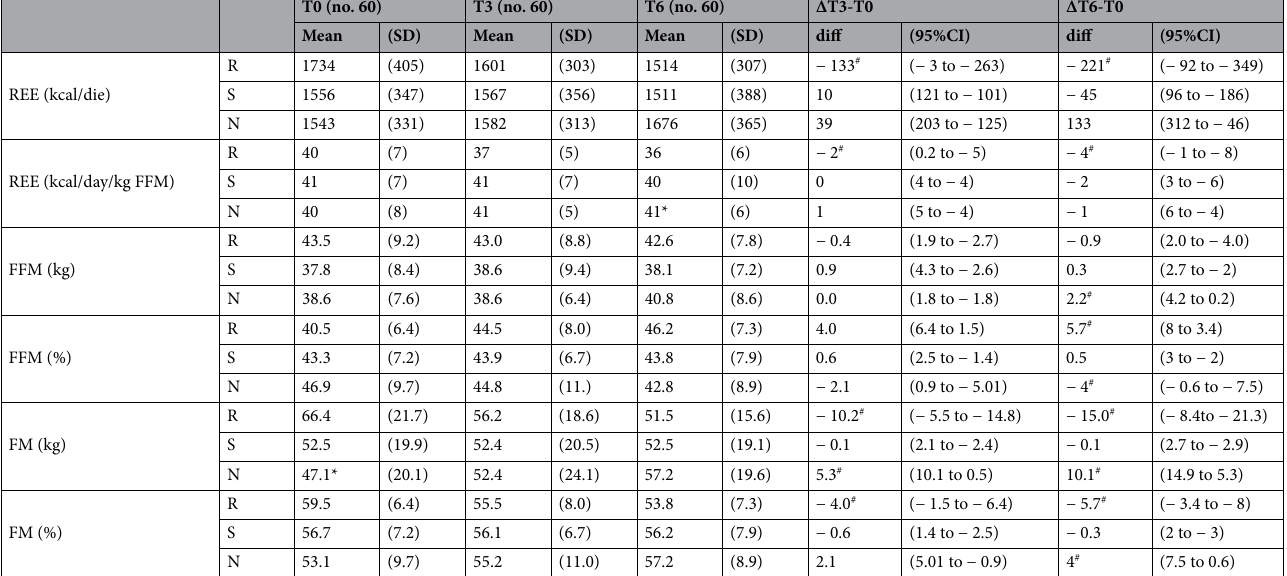
Table 2. Resting energy expenditure and body composition of Prader–Willi syndrome (PWS) patients at baseline, after 3 and 6 years follow-up. Measurements are reported as mean and standard deviation (SD), while changes are reported as mean difference and 95% confidence interval (CI). *: significantly different from the responsive subgroup ( p < 0.05); # : significantly changed compared to baseline. R: responsive patients; S: Stable patients; N: non-responsive patients; REE: resting energy expenditure; FFM: fat-free mass; FM: fat